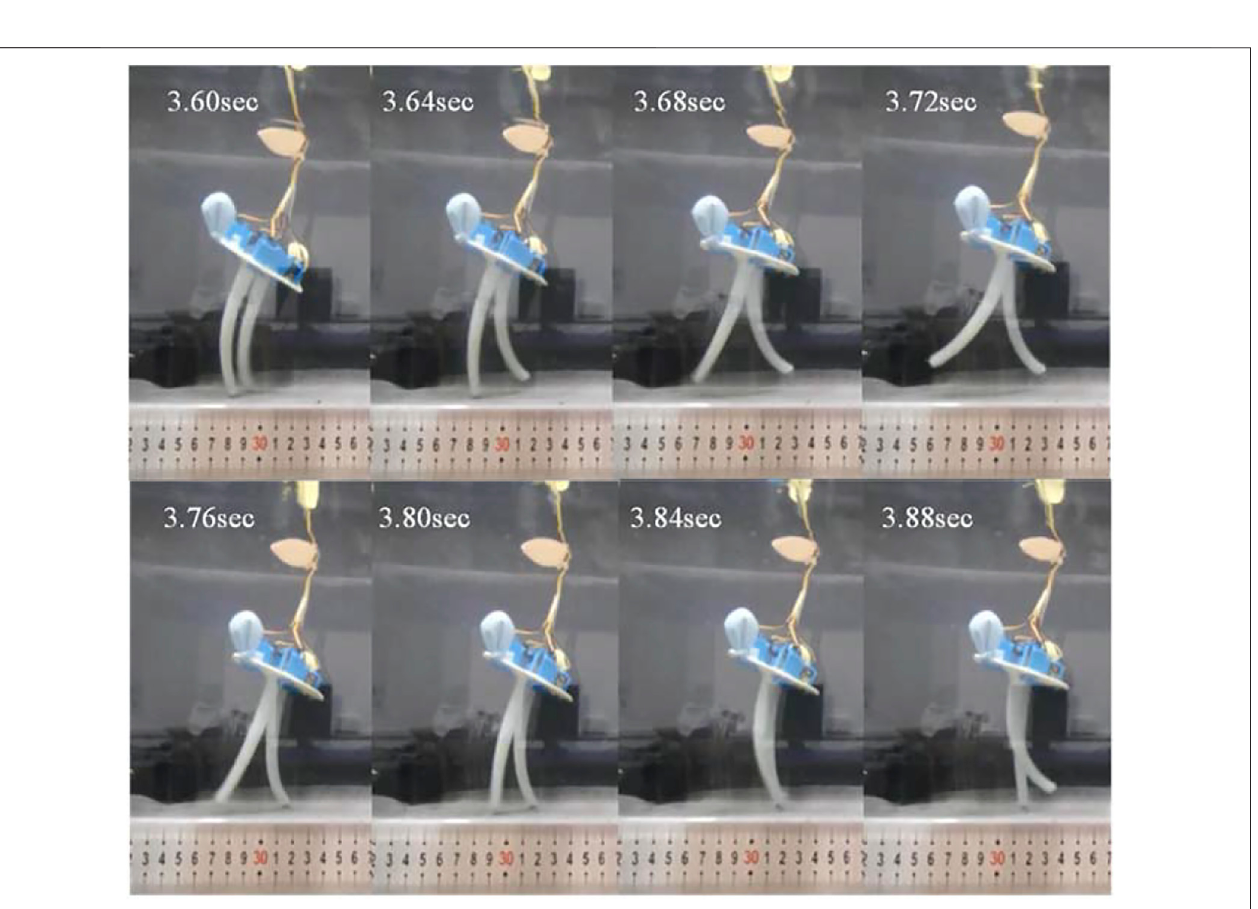
Frontiers in Robotics and AI |